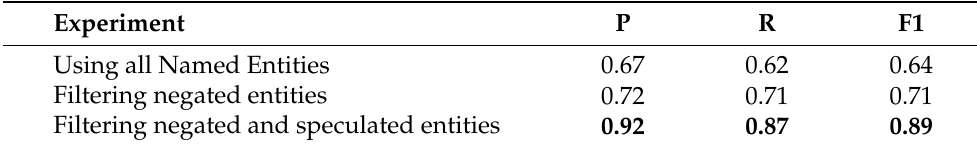
Table 6. Results for extracting the diagnosis